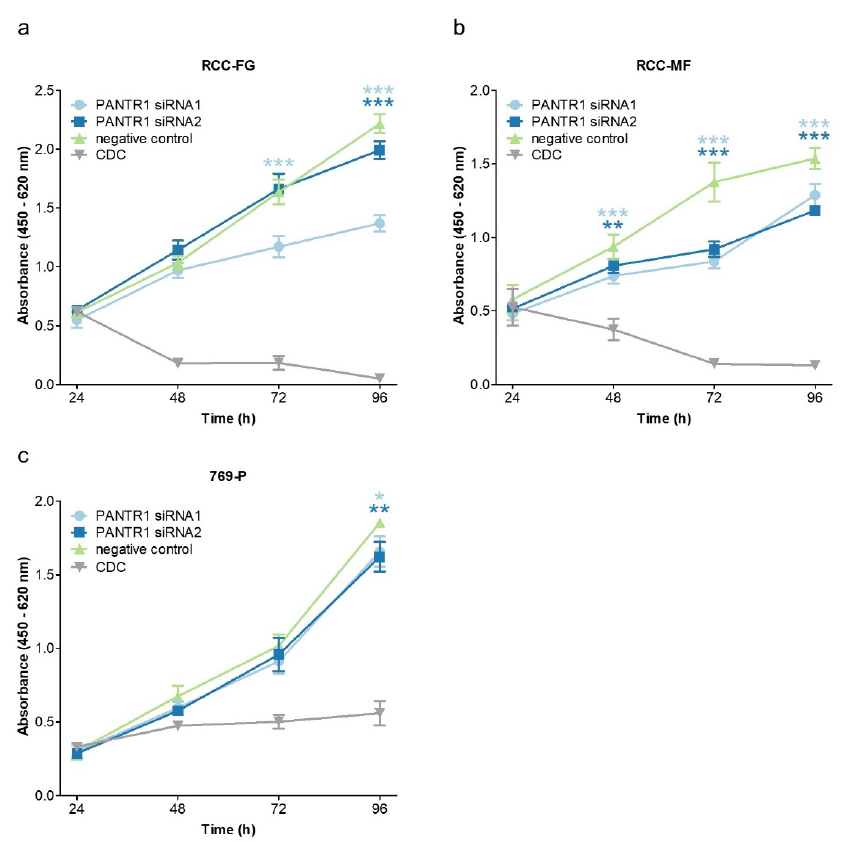
Figure 2. PANTR1 silencing reduces cellular growth in RCC cells. ( a – c ) WST-1 proliferation assay